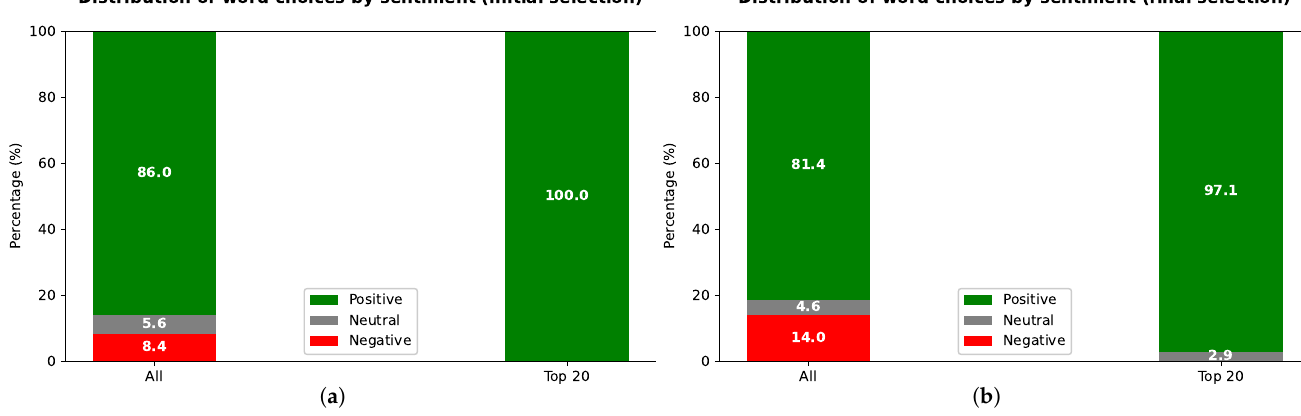
Figure 9. Word distribution according to their sentiment (positive, neutral, or negative), considering all words and only the twenty more frequently chosen words (top 20), for the ( a ) initial and ( b ) final selection of the 118-word